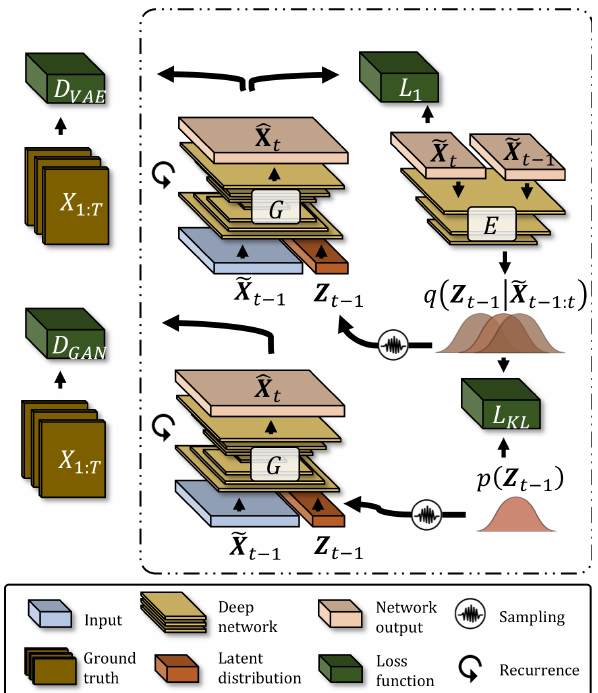
Figure 4. Illustration of the SAVP architecture (based on discussion in Lee et al.,